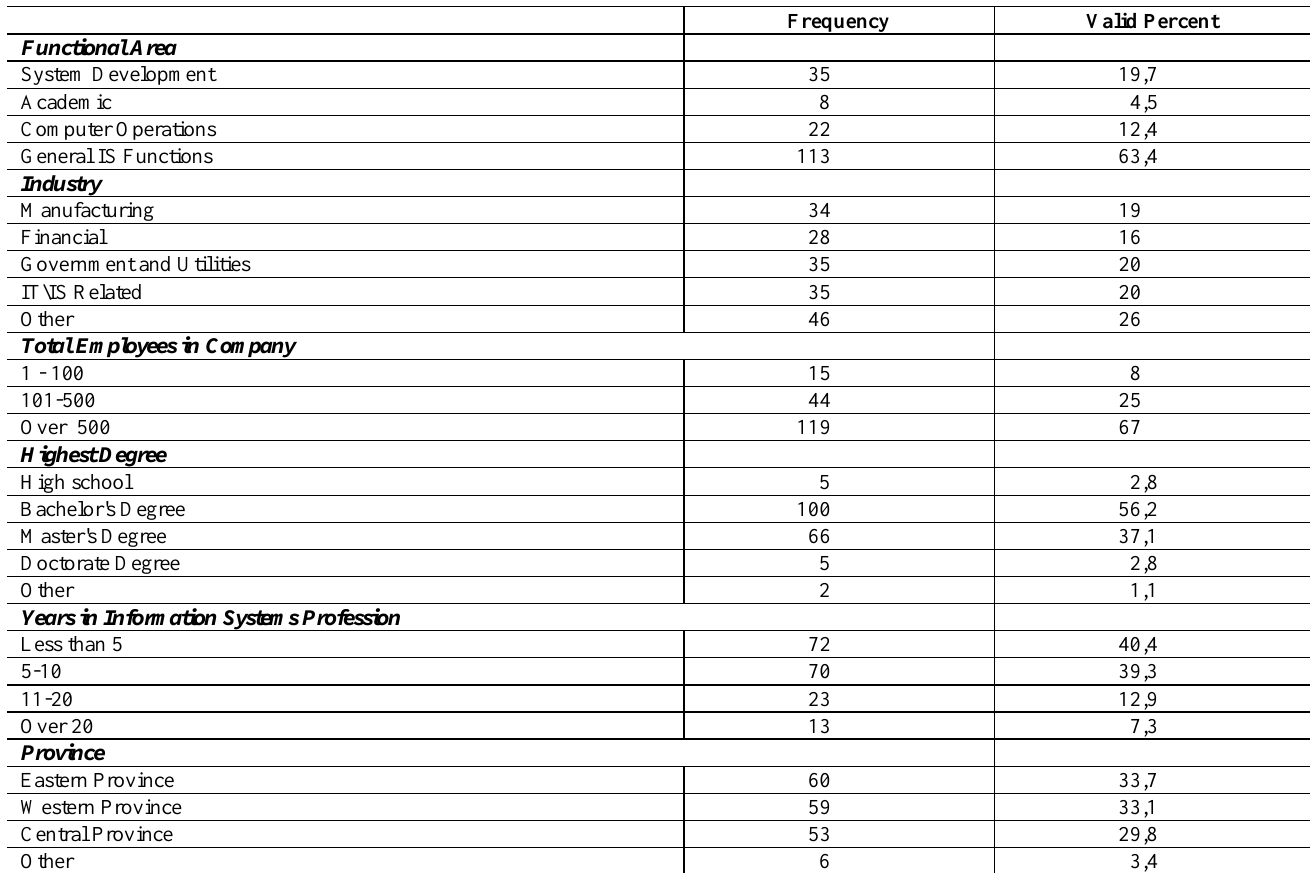
Table 1: Demographic profile of respondents